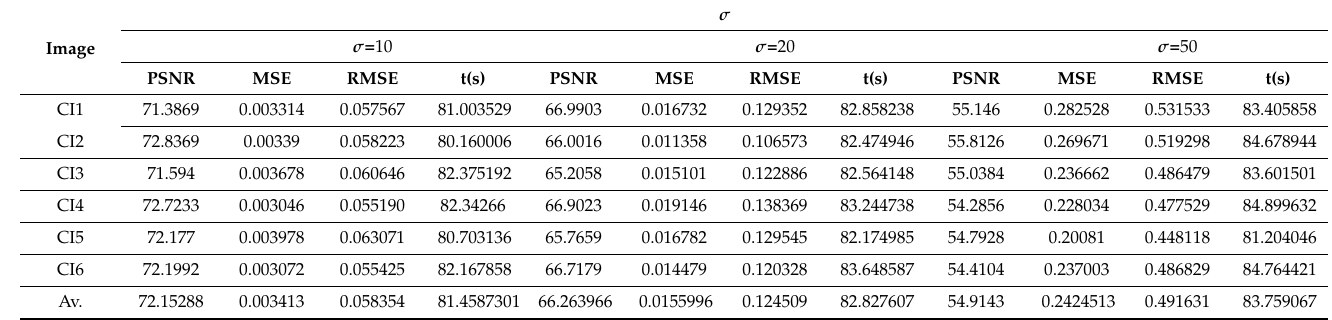
Table 3. Averaged quantitative de-noising results for six clinical images using the proposed